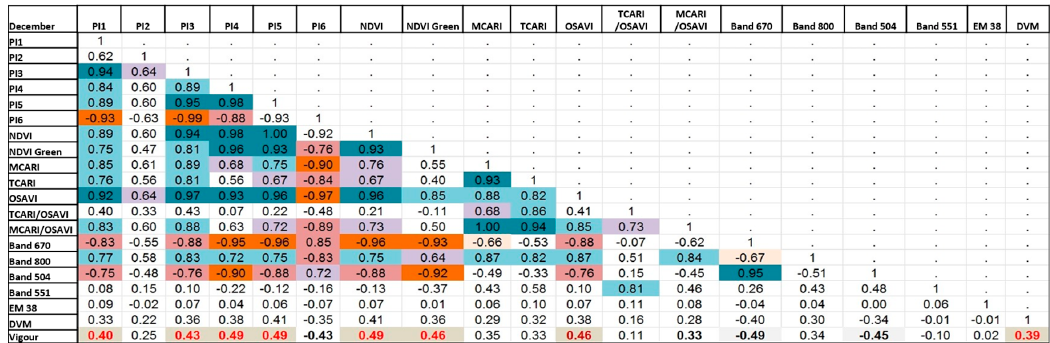
Figure 17. Pearson’s correlation coefficient matrix showing correlation between the hyperspectral vegetation indices and expert vigour assessment for data collected in December 2016. Orange colour indicates negative correlation; blue colour indicate positive correlation with the intensity of colour indicating relative strength and highlighted red font are the indices that correlate positively with the digital vigour model (DVM) and expert vigour assessment.